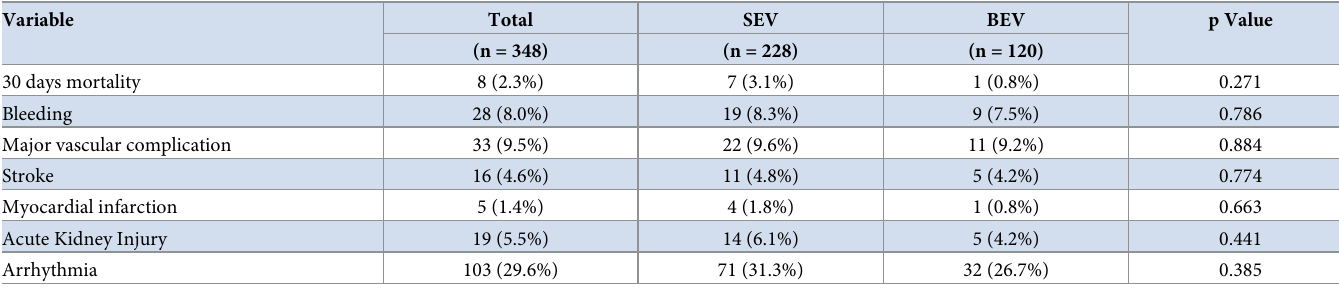
Table 5. Thirty-days outcomes of patients after TAVI, SEV vs. BEV ┼